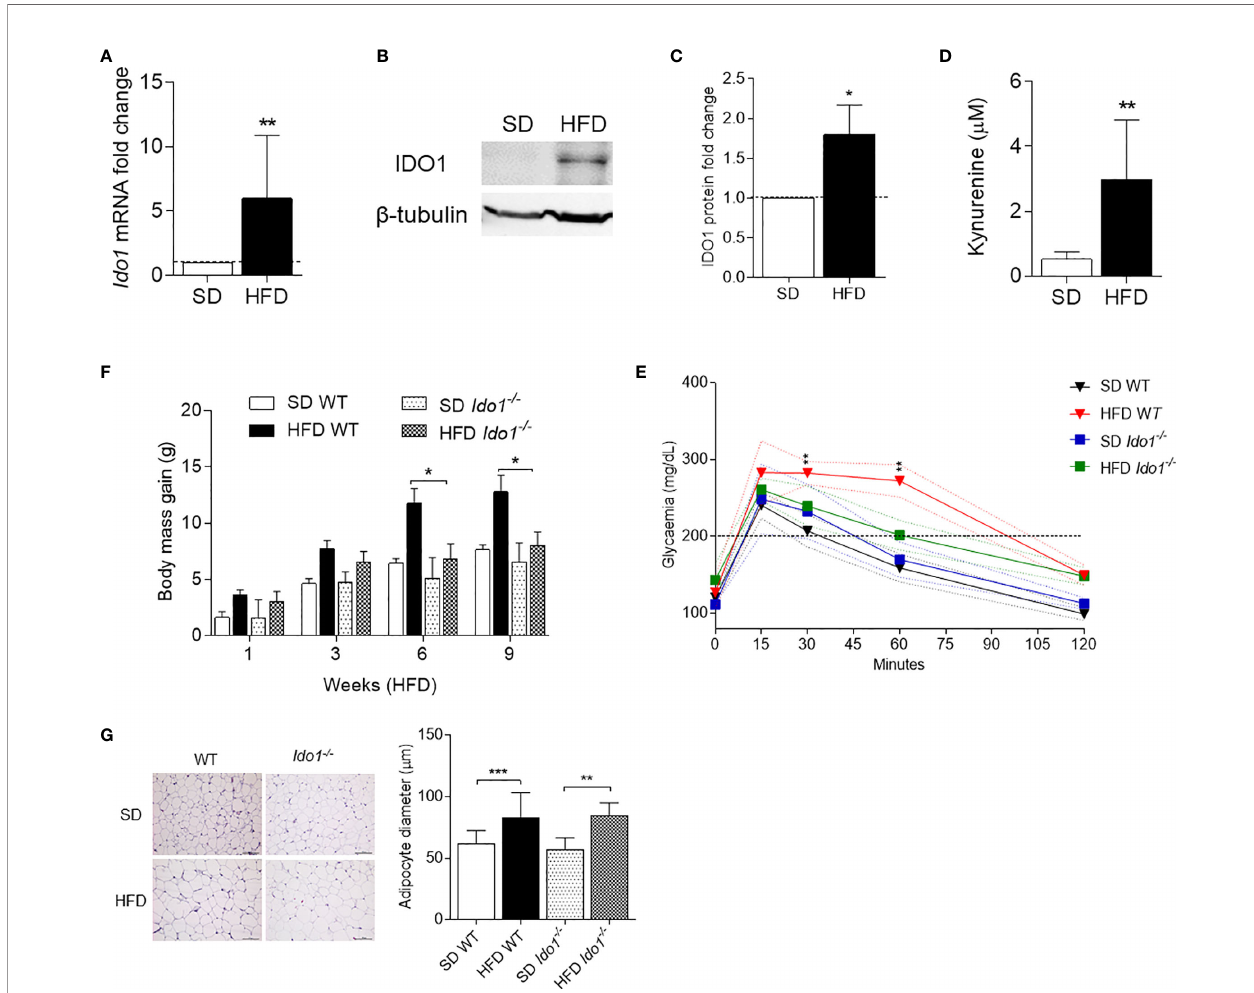
FIGURE 2 | IDO1 expression and activity in diet-induced obesity. Expression of IDO1 gene (A) and protein (B) in SVF WAT cells of HFD versus SD mice after 10 weeks of diet. (C) Quantitative analysis of immunoblots from two independent ex vivo experiments, one of which represented in (B) . Data (mean ± S.D., n = 3 biological replicates) represent the ratio of tubulin-normalized IDO1 protein in SVF WAT from mice on HFD to that expressed in SD control counterparts. (D) Levels of Kyn (mean ± S.D., n = 3 biological replicates) secreted by SVF WAT cells in 24-h culture supernatants. * p < 0.05, ** p < 0.01, HFD versus SD (two-tail unpaired Student ’ s t test for C , D ). (E) Body weight gain of WT and Ido1 − / − mice throughout 9 wk of high-fat diet (HFD, n = 10) treatment compared with gender- and age- matched controls fed with a standard diet (SD, n = 10). * p < 0.05, HFD WT versus HFD Ido1 − / − mice, ANOVA followed by post hoc Bonferroni ’ s method. (F) Intraperitoneal glucose tolerance test (IPGTT) after 9 wk of HFD ( n = 5, from two independent experiments). Glycaemia (mg/dl) at different time points (0, 15, 30, 60, and 120 min) from the administration of glucose. (G) Hematoxylin and eosin staining of visceral WAT (left panel, scale bars are 100 m m.). Analysis of adipocyte diameter (right panel). ** p < 0.01, *** p < 0.001 HFD versus SD mice per genotype (ANOVA followed by post hoc Bonferroni ’ s method for F, G